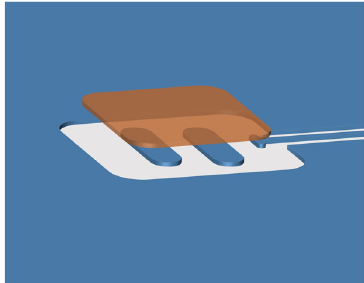
Fig. 3 A schematic picture of a transmon prepared by the fl ip-chip process. It consists of two substrates with patterned tantalum fi lms. The two substrates are packaged face-to-face with indium bumps using the fl ip-chip technology. The Josephson junction is located between the two pads (blue color) on the bottom substrate (Josephson junction is not shown in this picture), and the Ta fi lm pattern (orange color) on the upper substrate is located directly above the two pads of the bottom substrate. The purpose of this is to increase the SPR of the MA interface because there is an electric fi eld that is localized between the upper and lower